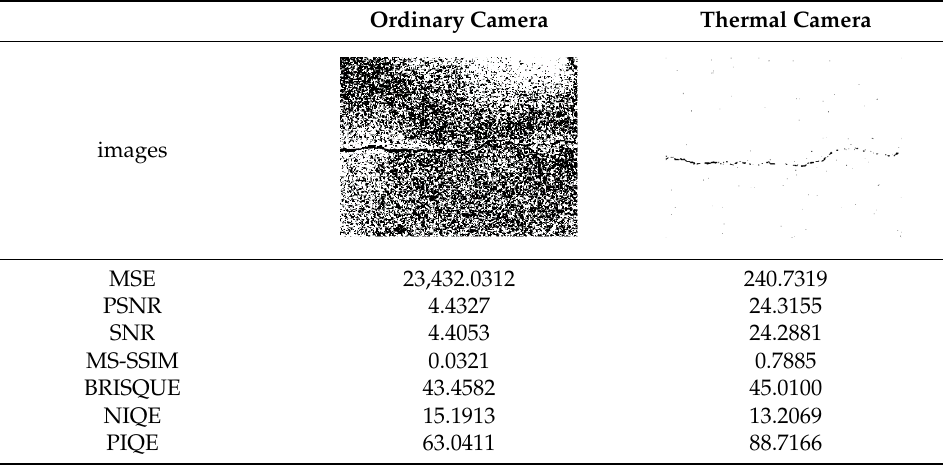
Table 2. Image quality metrics.